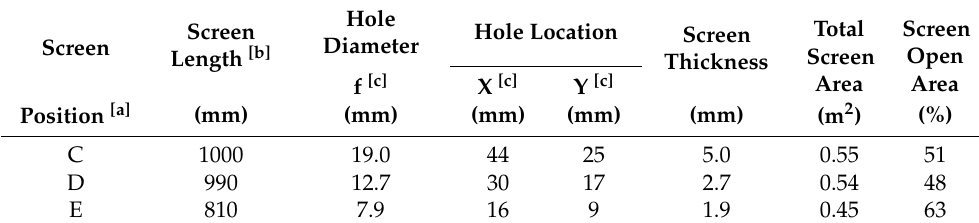
Table 1. Properties of screens used in the final configuration of the gyratory screener.